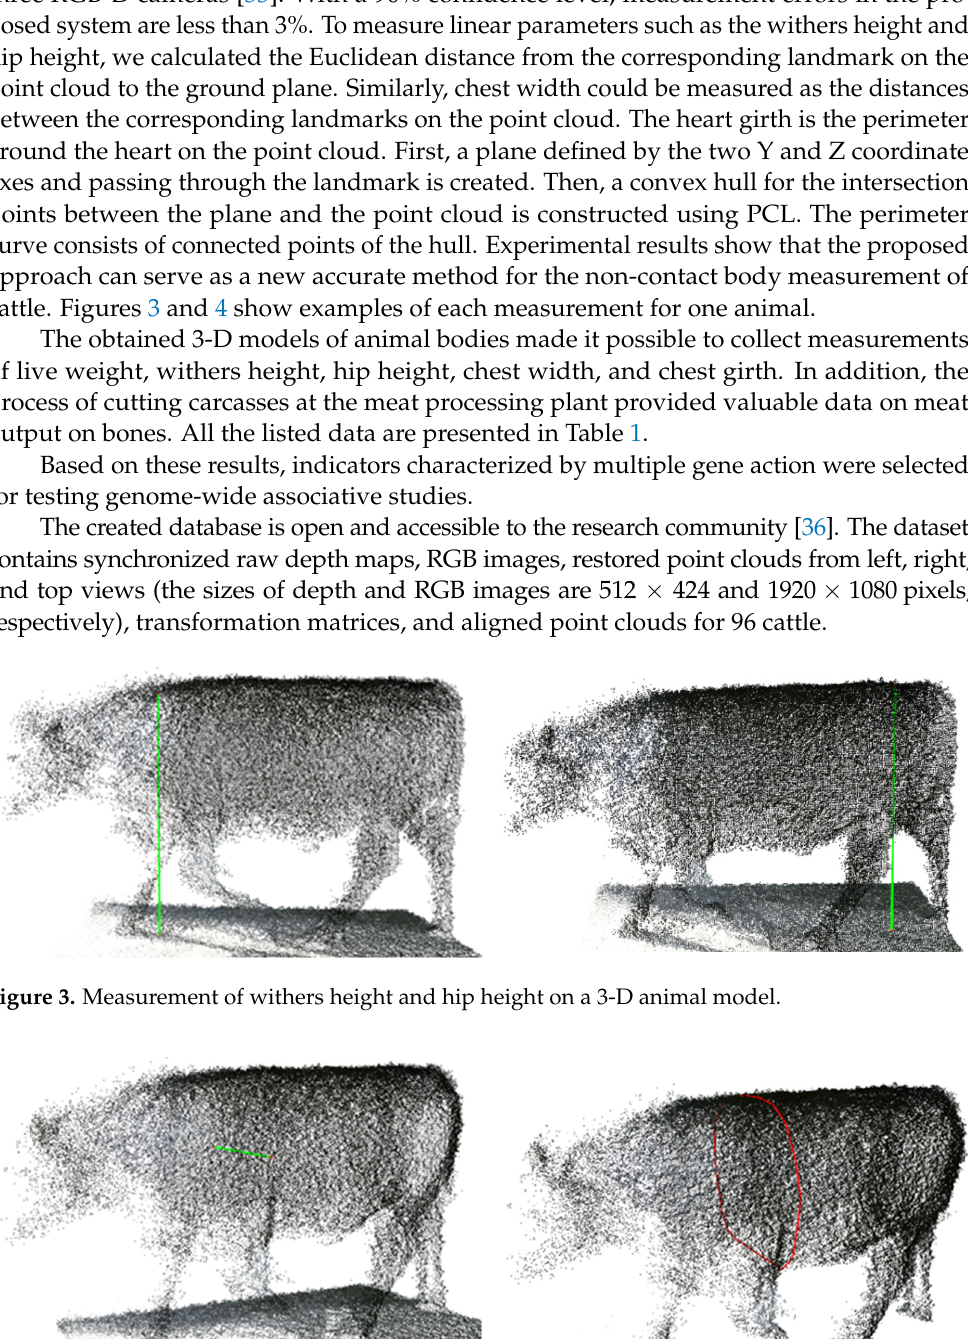
Figure 4. Measurement of chest width and chest girth on a 3-D animal model.